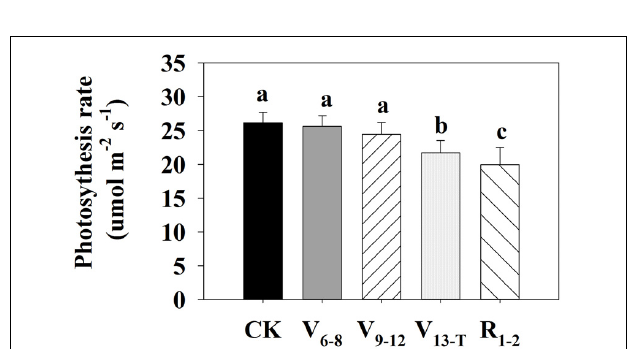
FIGURE 2 | Photosynthetic rate at 85 days after sowing (mid grain-filling stage) in 2016. CK, well-irrigated treatment; V 6 − 8 , water deficit during the 6–8-leaf stage; V 9 − 12 , water deficit during the 9–12-leaf stage; V 13 − T , water deficit from the 13-leaf stage to tasseling stage, R 1 − 2 , water deficit from silking stage to blister stage. Values with different letters are significantly different at P <